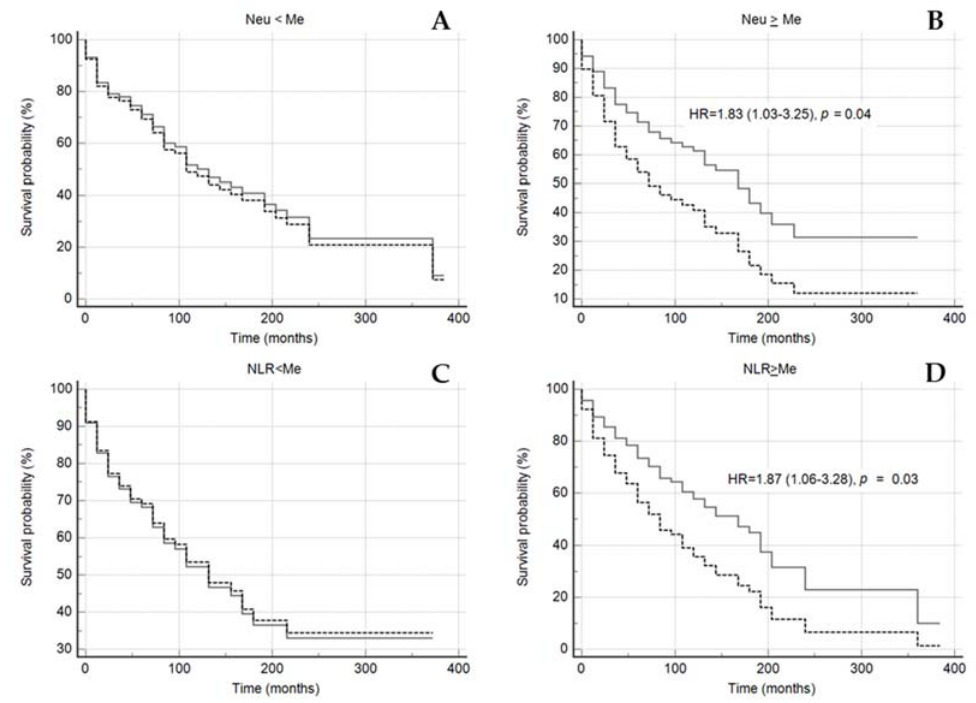
Figure 6. Kaplan–Meier survival without events curves in subgroups of patients with neutrophils count < median ( A ) or ≥ median ( B ), NLR < median ( C ) or ≥ median ( D ) depending on the of Lp(a) < 30 mg/dL (grey solid line) and Lp(a) ≥ 30 mg/dL (black dotted line). NLR—neutrophil-to-lymphocyte ratio, NEU—neutrophil, Me—median. Median for NLR 2.66, for Neu 5.04 × 10 9 /L. Sex, age of CHD manifestation, statin medication was included in model of Cox proportional regression.